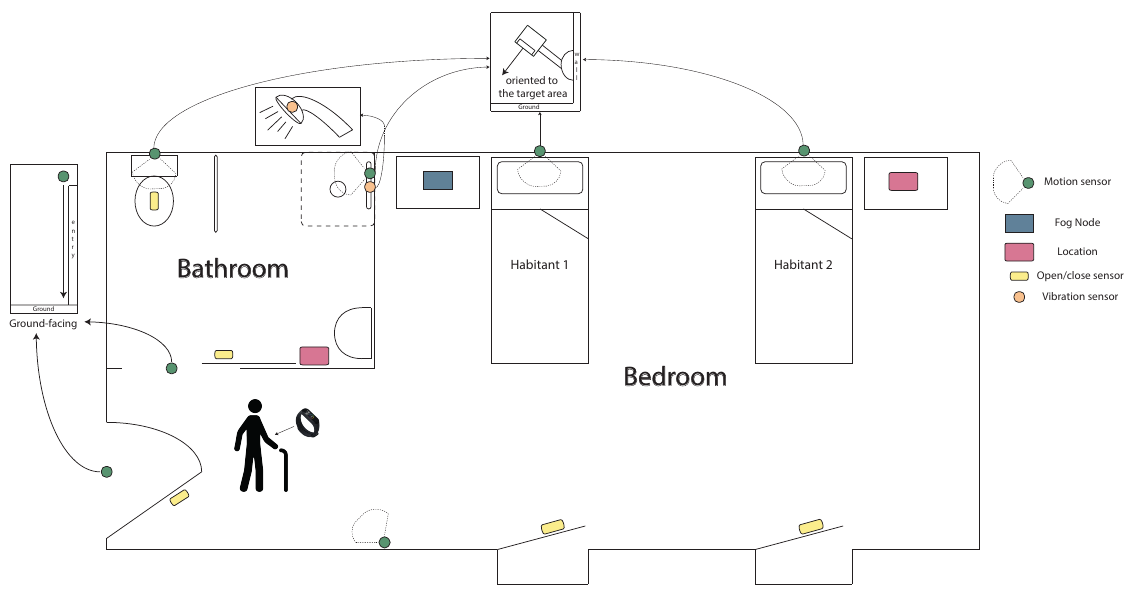
Figure 3. Location of the devices in each shared